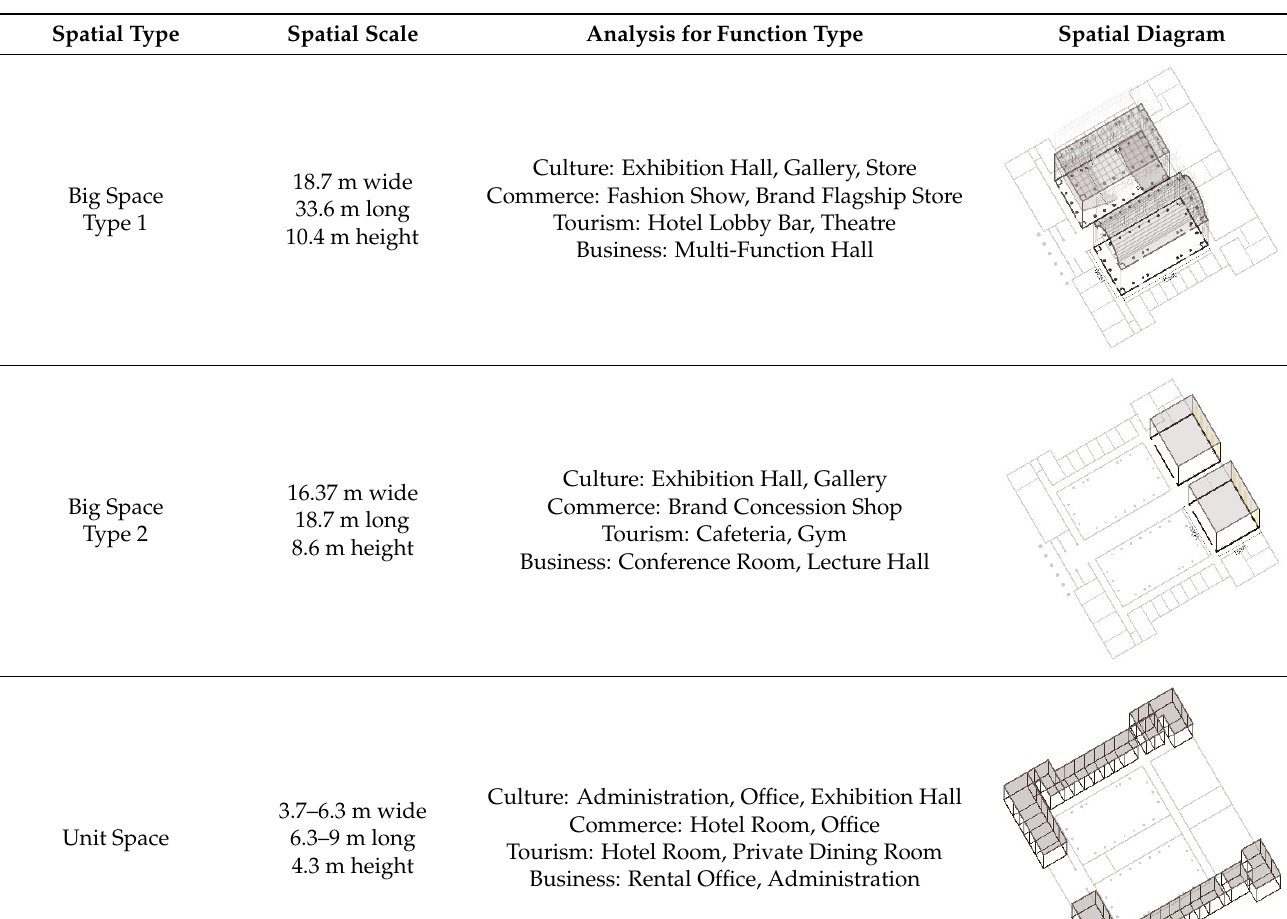
Table 3. Main Spatial Types in Qingdao Exchange Building.